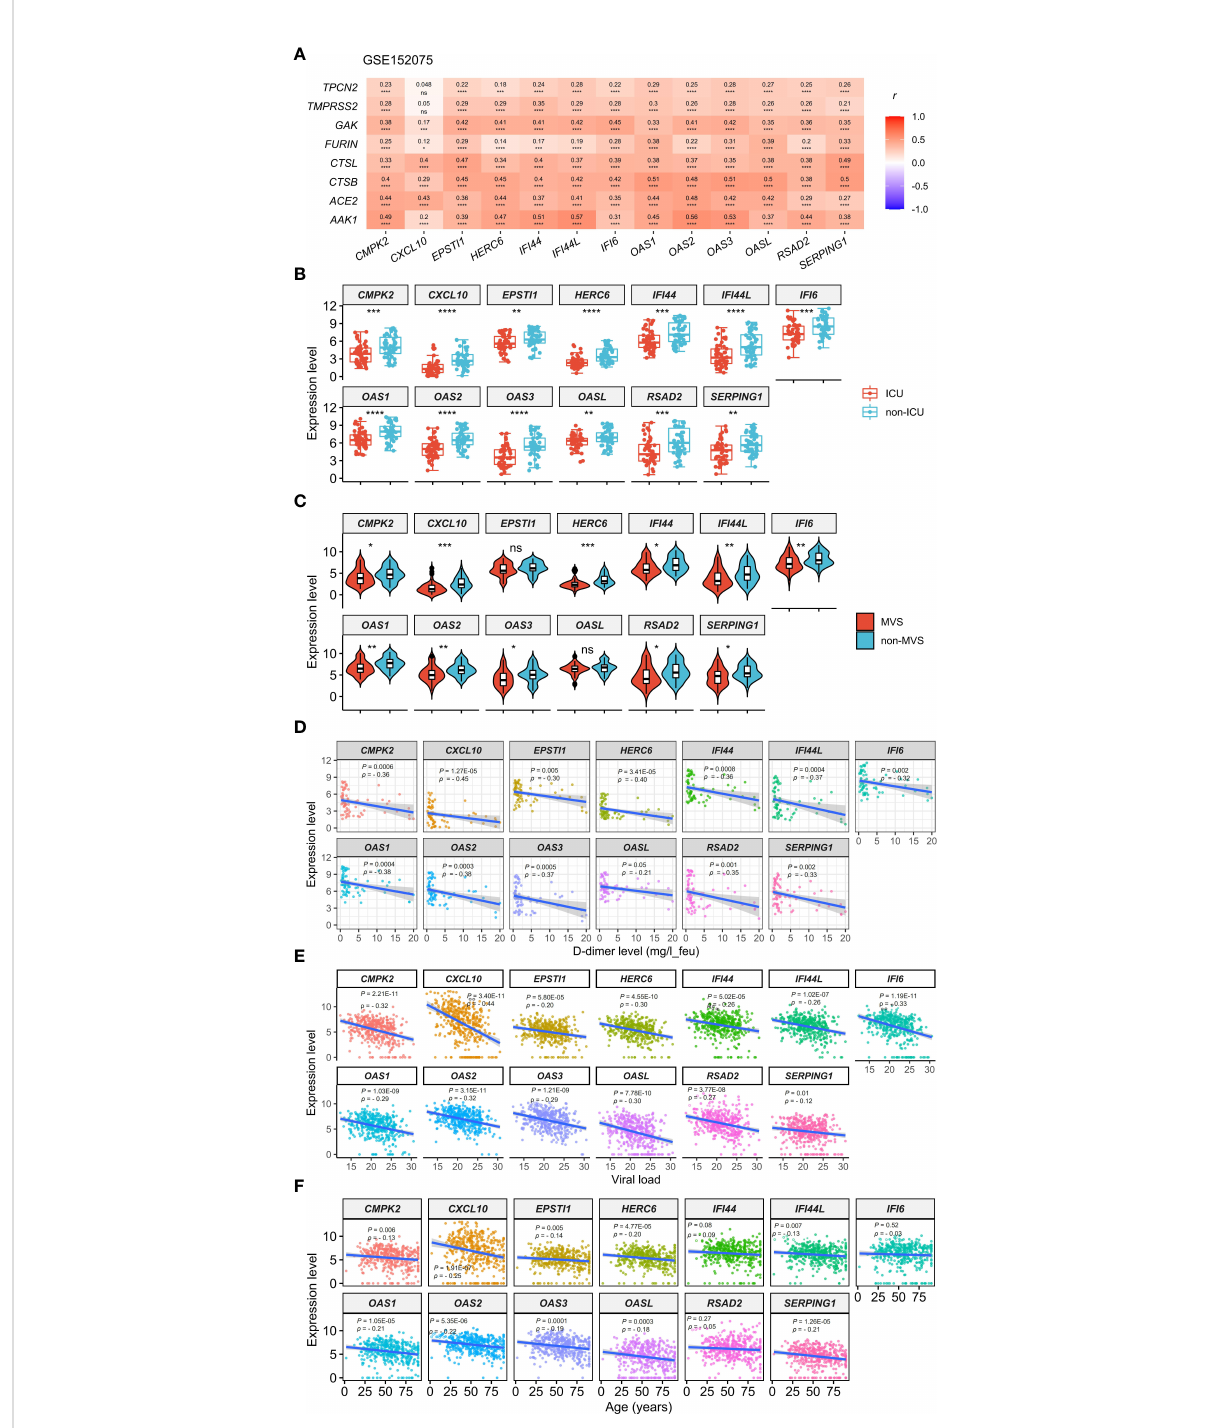
FIGURE 1 Expression correlations of the 13 genes upregulated in COVID-19 patients with the key regulators of SARS-CoV-2 infection and clinical features of COVID-19 patients. (A) Heatmap showing expression correlations between the 13 genes and 8 key regulators of SARS-CoV-2 infection in GSE152075. Pearson correlation coef fi cients ( r ) and P -values are shown. (B, C) Comparisons of the 13 genes ’ expression levels between ICU and non-ICU, and between MVS and non-MVS COVID-19 patients. Two-tailed student ’ s t test P -values are shown. (D – F) Expression correlations of the 13 genes with D-dimer levels, viral loads, and ages of COVID-19 patients. Spearman correlation coef fi cients ( r ) and P -values are shown. The results shown in (B – F) were obtained by analyzing the dataset GSE157103. ICU, intensive care unit; MVS, mechanical ventilatory support. * P < 0.05, ** P < 0.01, *** P < 0.001, **** P < 0.0001, ns: not signi fi cant. They also apply to the following fi